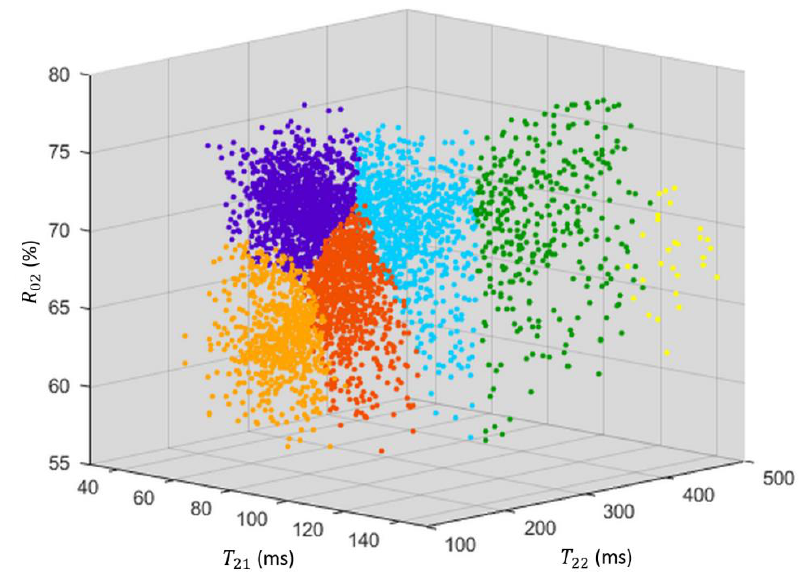
Figure 5. T 21 , T 22 and R 02 for each voxel with the corresponding color class for WAH 14. Colors were attributed regarding both T 22 and spatial information as detailed in the text. On average, purple Figure 5. 𝑇 21 ,𝑇 22 and 𝑅 02 for each voxel with the corresponding color class for WAH 14. Colors were could be attributed to cortex, green to the pith and yellow to the defects, the three other colors, light attributed regarding both 𝑇 22 and spatial information as detailed in the text. On average, purple and dark orange and cyan, to the flesh.